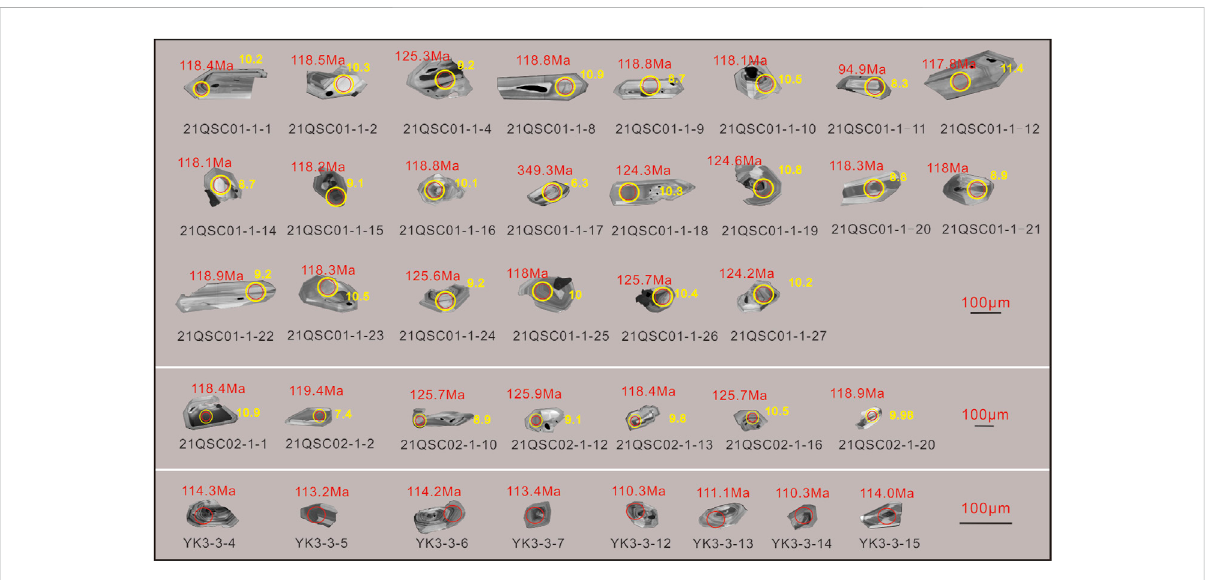
FIGURE 5 Representative zircon cathodoluminescence(CL)images (red circles for U-Pb dating fi eld, yellow circles for Lu-Hf analytical